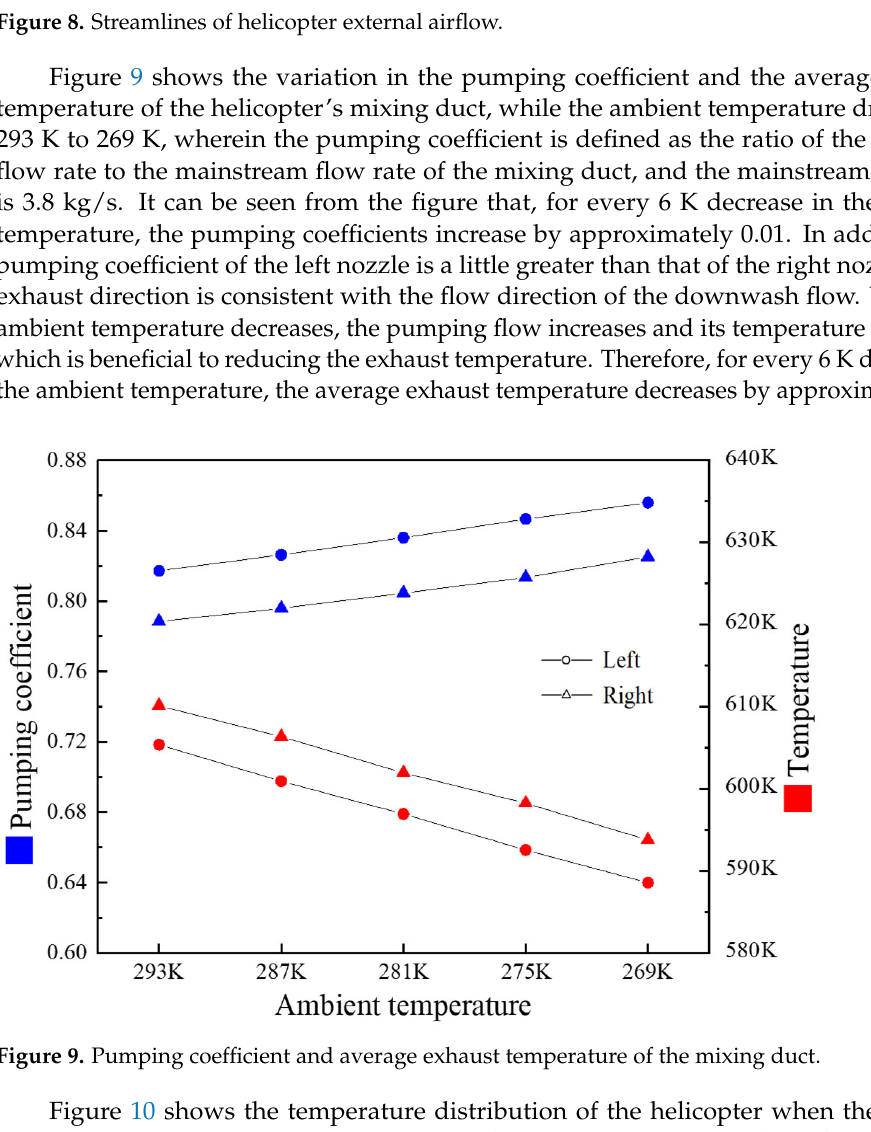
Figure 8. Streamlines of helicopter external air fl ow.